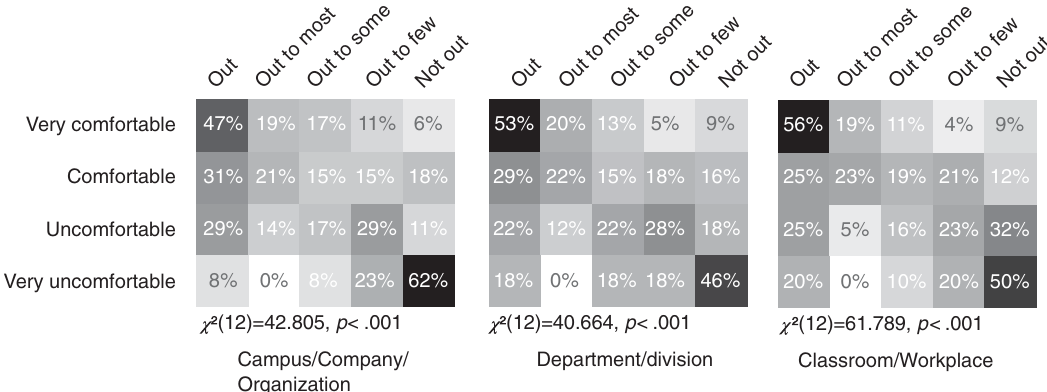
FIG. 7. Relationship between participant comfort level and their degree of outness in different institutional